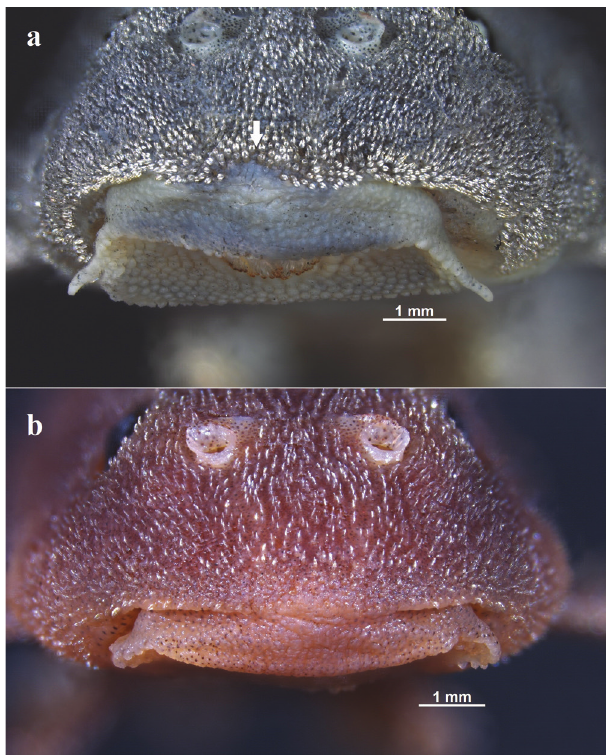
Fig. 7. Anterior view of rostrum of: a. Parotocinclus seridoen- sis , MZUSP 113424, 33.4 mm SL, showing an area deprived of odontodes (arrow) at the anterior border of the snout; b. Parotocinclus spilurus , UFPB 336, 29.6 mm SL, with anterior border of the snout covered by